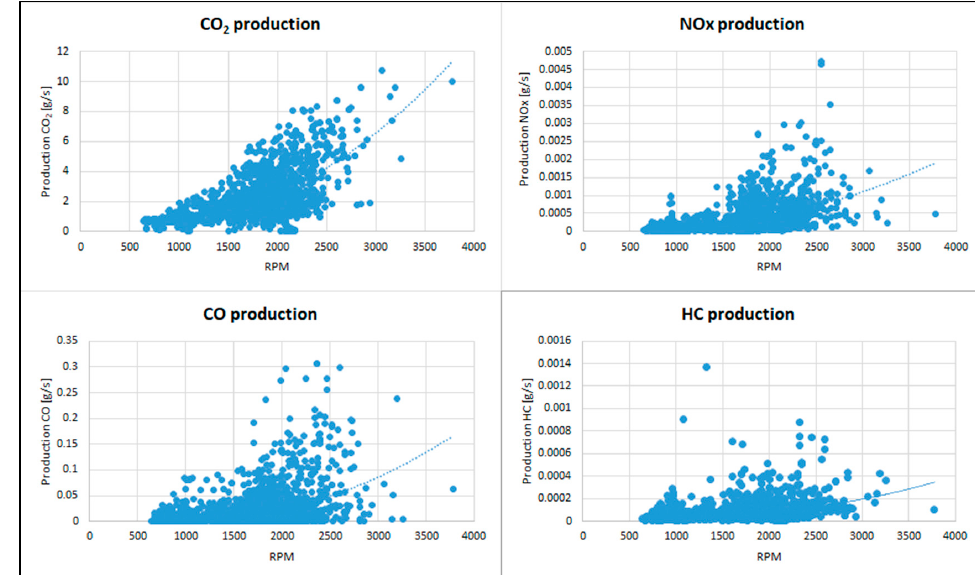
Figure 17. Comparison of emission production depending on engine speed—LPG, urban cycle .